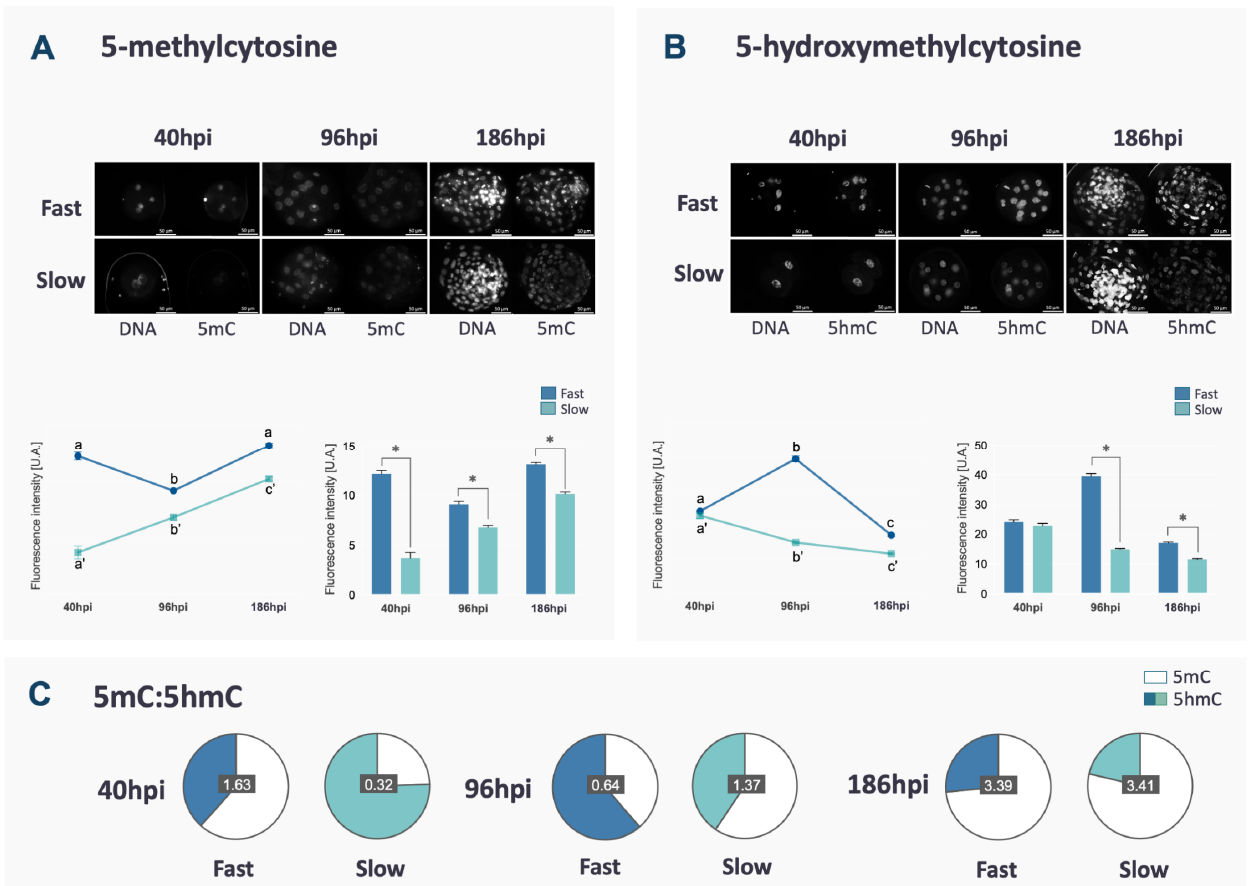
× ) of 5mC ( A ) and 5hmC ( B ) of fast and slow embryos at 40, 96 and 168 hpi. Figure 1 Figure 1. Fluorescence intensity and representative images (original magnification 400 Nuclei were stained with propidium iodate and immunostained with antibodies against 5mC or 5hmC. Fluorescence levels for each mark are represented. Di ff erences among time points within the same group are indicated by lower case letters (a, b, c) and those between fast and slow embryos for each time point are indicated with *. Data are represented as mean ± S.E.M. The ratio between 5mC and 5hmC for each group in each time point is represented in ( C ) to demonstrate the overall change in proportion between the two marks along the development, although the proportion of 5mC and 5hmC was not statistically